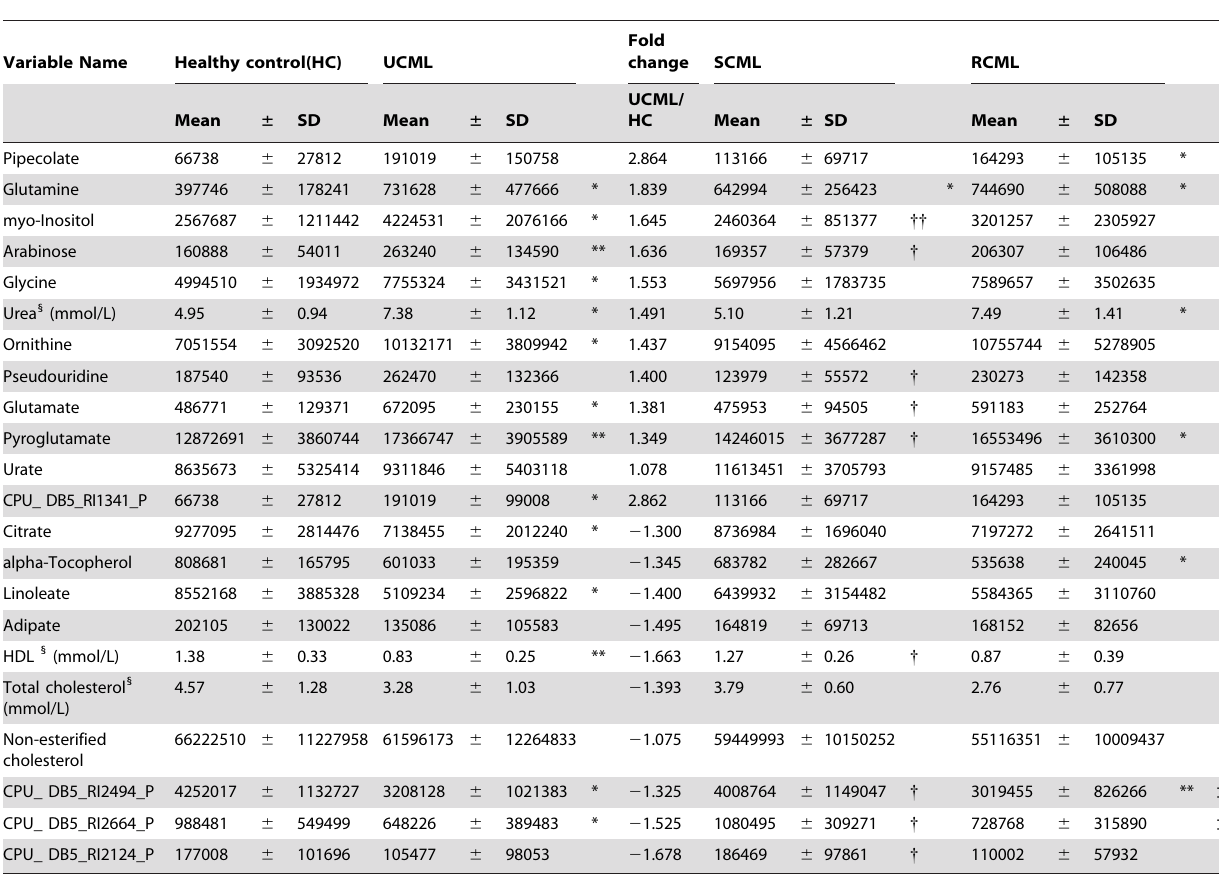
Table 3. The relative abundance of the identified compounds/peaks differentiating UCML from HC and the regulation by imatinib.